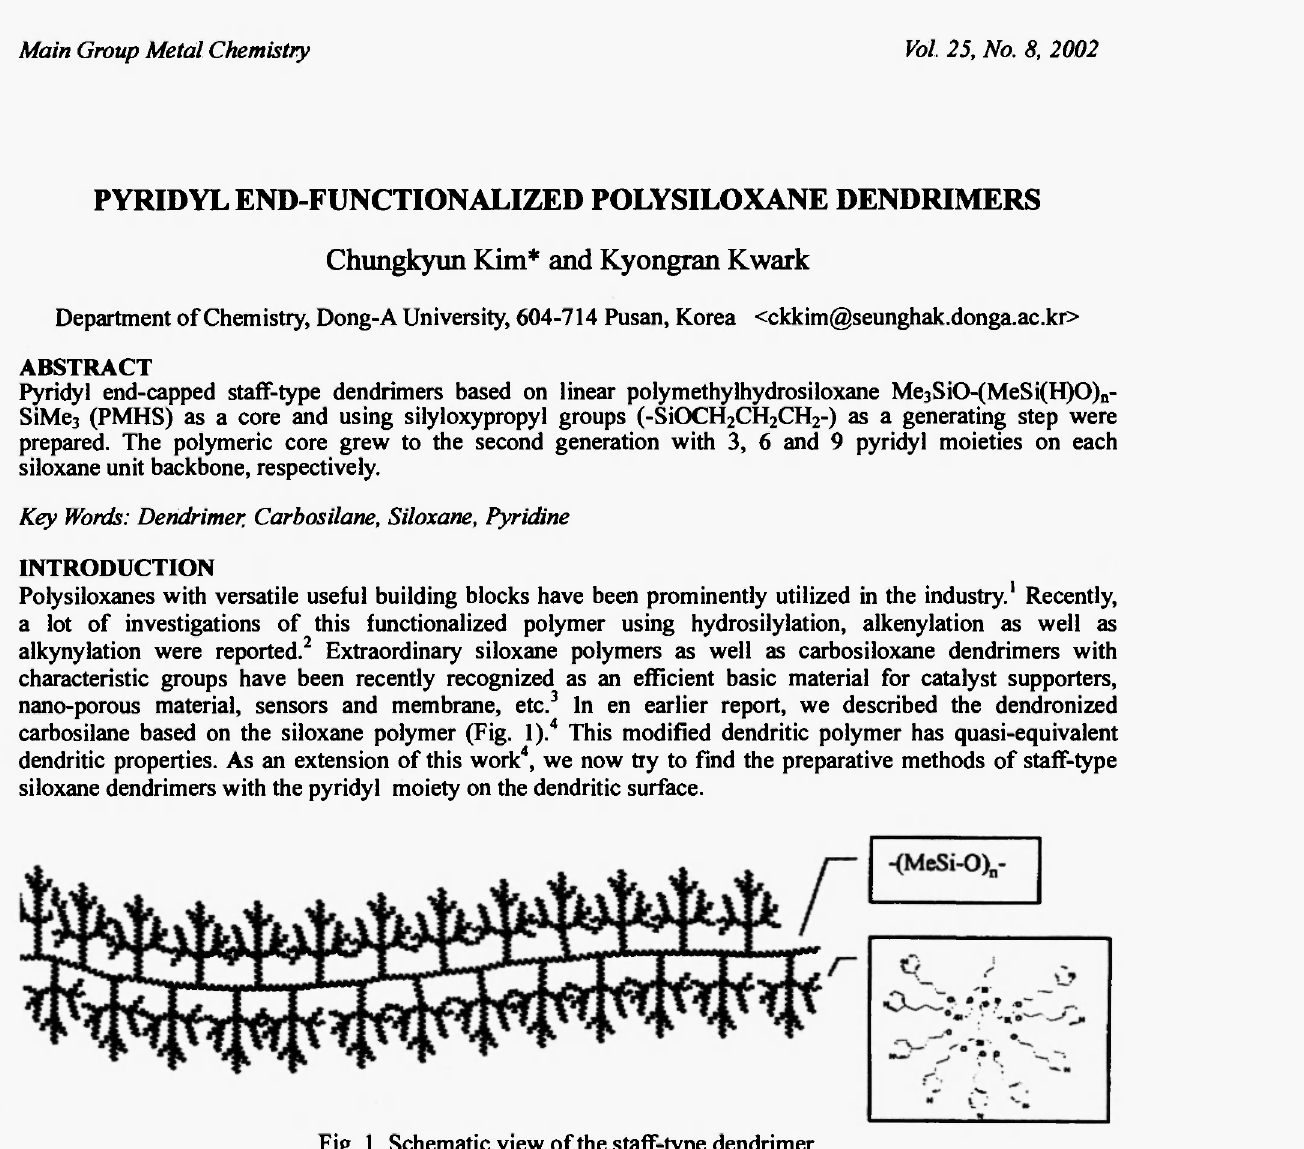
Fig. 1. Schematic view of the staff-type